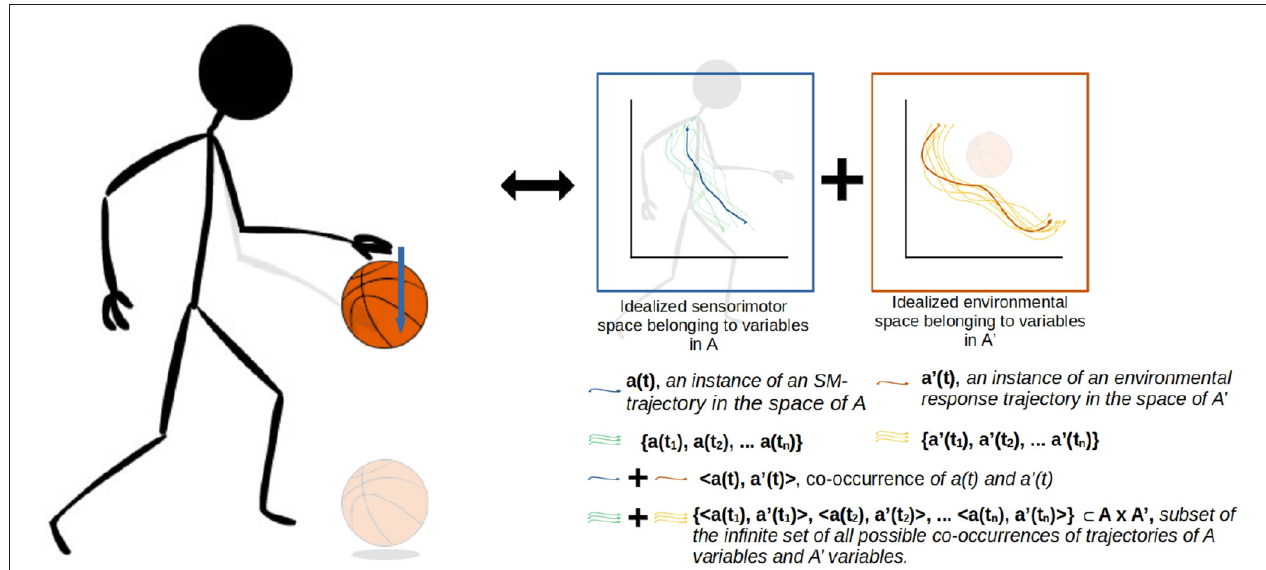
FIGURE 2 | A more detailed visualization of the A × A’ coordination from the previous figure. The coordination captures not just the agent’s actions (A) and sensations but also the environmental processes that happen concurrently (A’). The state spaces represent theoretical projections of the state spaces of the relevant variables on the agent-side and environment-side of the engagement. The trajectories are not just co-occurring but also circularly causal, with the sensorimotor trajectory being a function of both internal (e.g., neuromuscular) dynamics and the environmental impacts on the agent’s body, and similarly the environmental trajectory being a function of both the agent’s actions and environmental processes such as gravity acting upon the